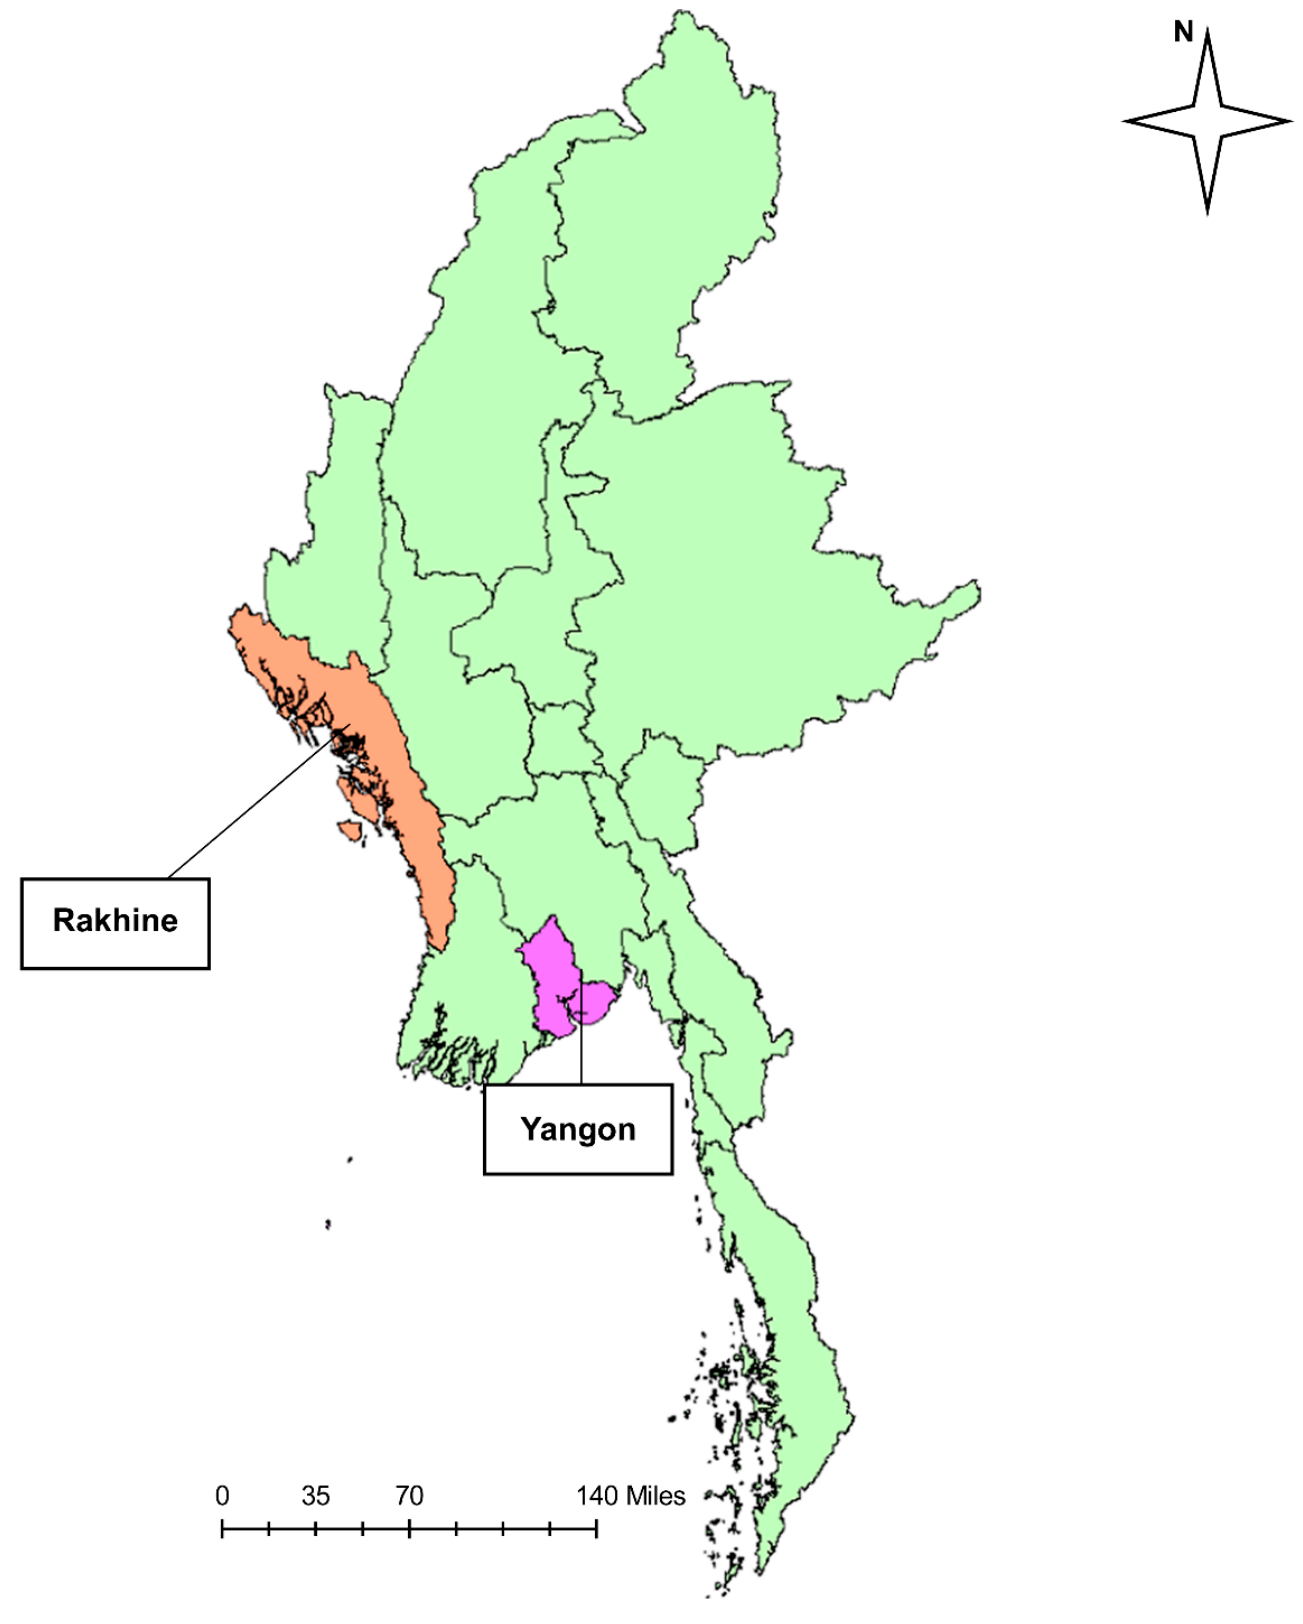
Figure 1. Location of Rakhine State (orange) and Yangon (pink) in Myanmar. Source: This map was generated by ArcMap 10.0 software (ESRI, Tokyo, Japan).